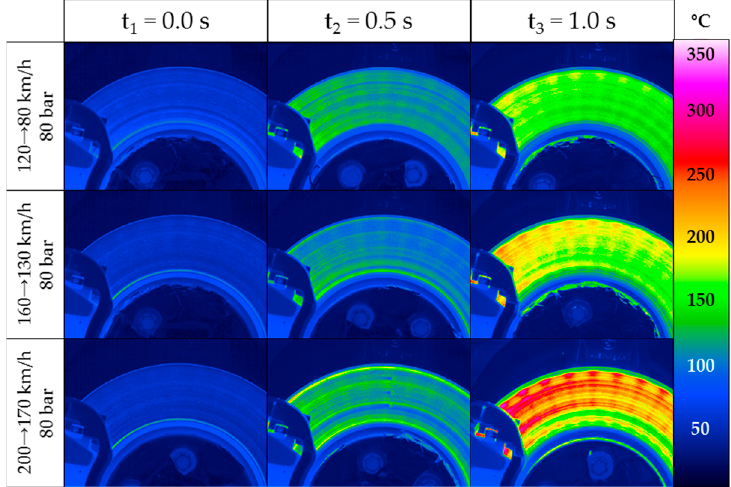
Figure 2. Temperature distribution over the disc surface—Speed variation at 80 bar [24]. Table 1. PMP (Particle Measurement Program) temperature specifications for brake discs during trip #10 of the WLTP (Worldwide harmonized Light-Duty vehicles Test Procedure) brake cycle (IBT = initial brake temperature; FBT = final brake temperature) [14,26].